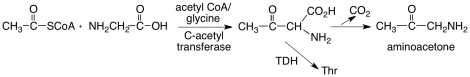
Condensation of acetyl-CoA and glycine to form the intermediate, 2-amino 3-ketobutyrate, a precursor of aminoacetone formation.Threonine dehydrogenase (TDH) normally catalyzes the reduction of 2-amino 3-ketobutyrate to form threonine and prevents its buildup; however, TDH is an inactive pseudo-gene in humans.